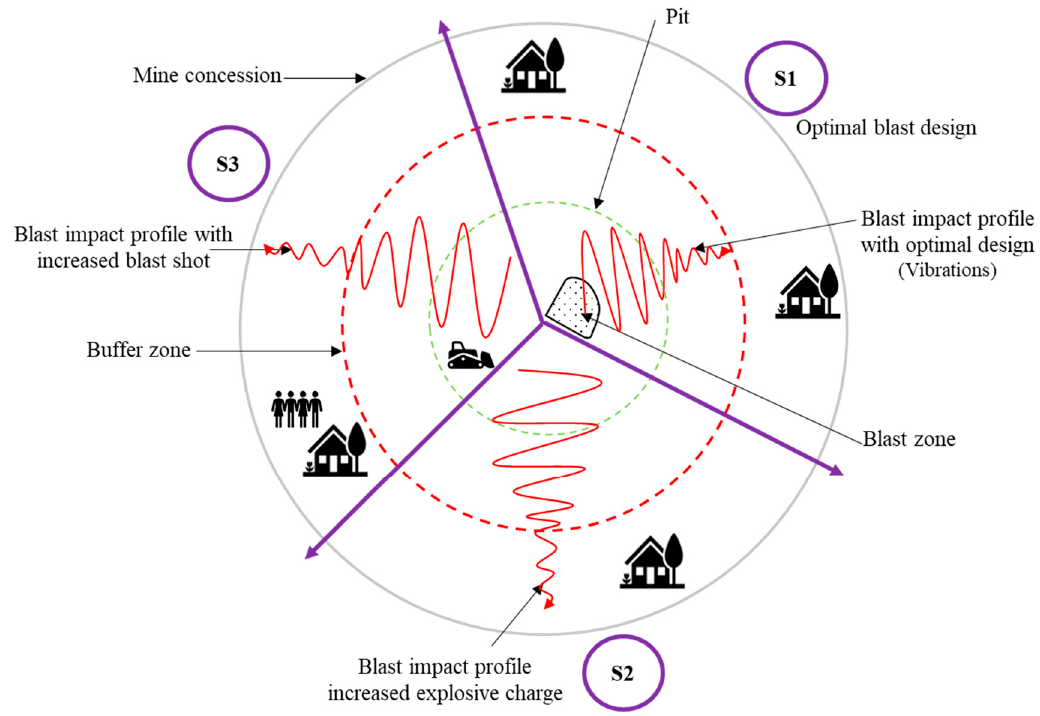
Figure 2. Blast impact zones and objects of concern. Varying blast design parameters (S1, S2, and S3) influence the magnitude and travel distance of undesirable blast effects.